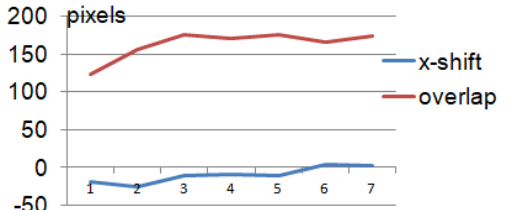
Figure 13: Average X-shift and overlaps without the first two images of the data sets 1 to 7 used, based on a pixel size of 6.5